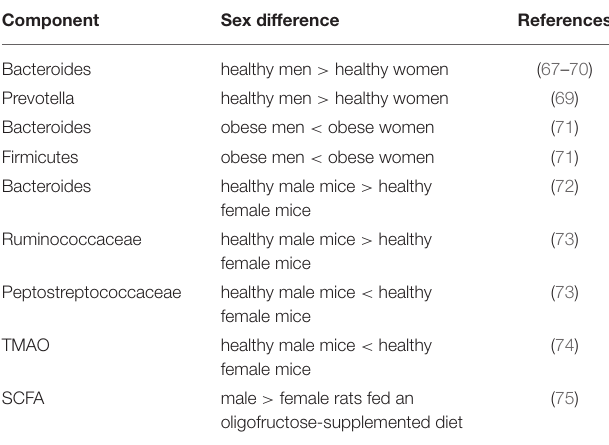
TABLE 1 | Sex differences in the gut